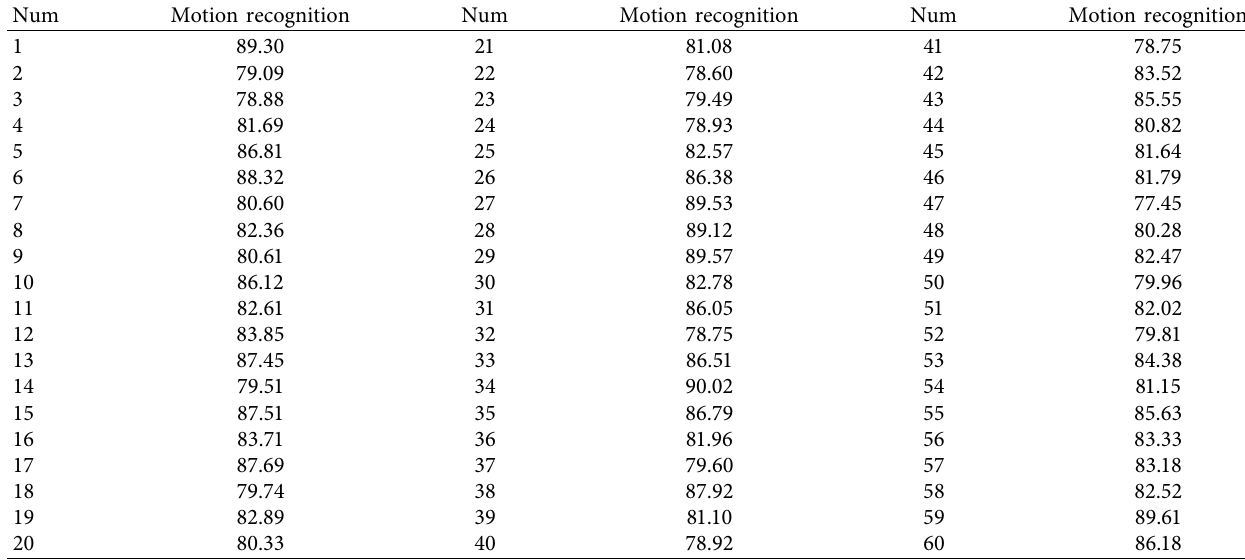
Table 1: Verification of recognition effect of motion pattern recognition model based on artificial visual neural network.